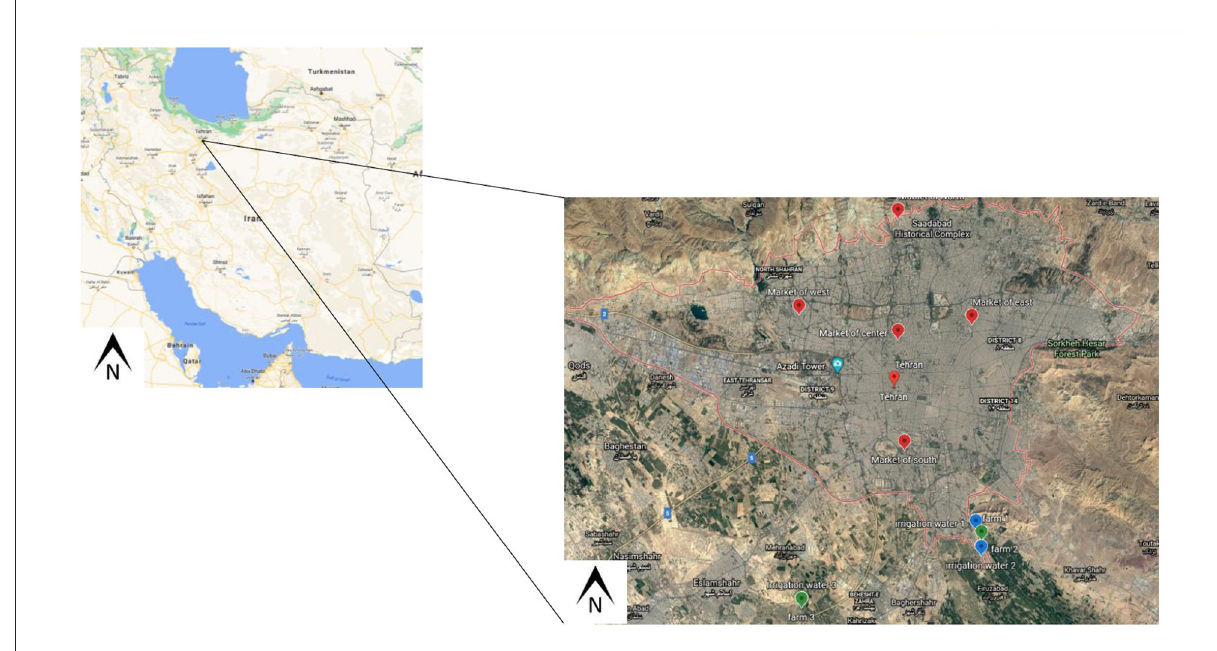
FIGURE2 Maps of Tehran, Iran showing the locations where the samples were collected (Locations of fruit and vegetable centers, fields and irrigation water are shown in red, green, and blue,